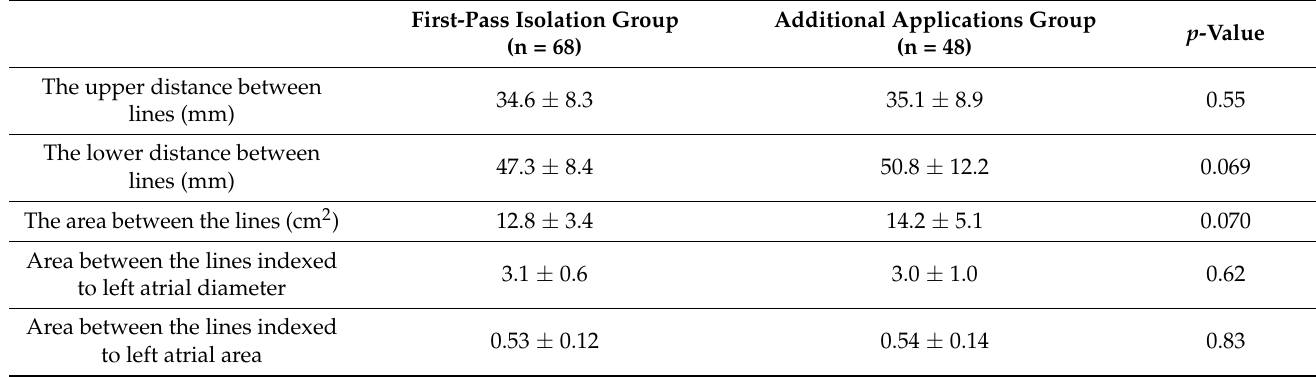
Table 2. Analysis of the impact of the distance between lines on first-pass isolation rate.